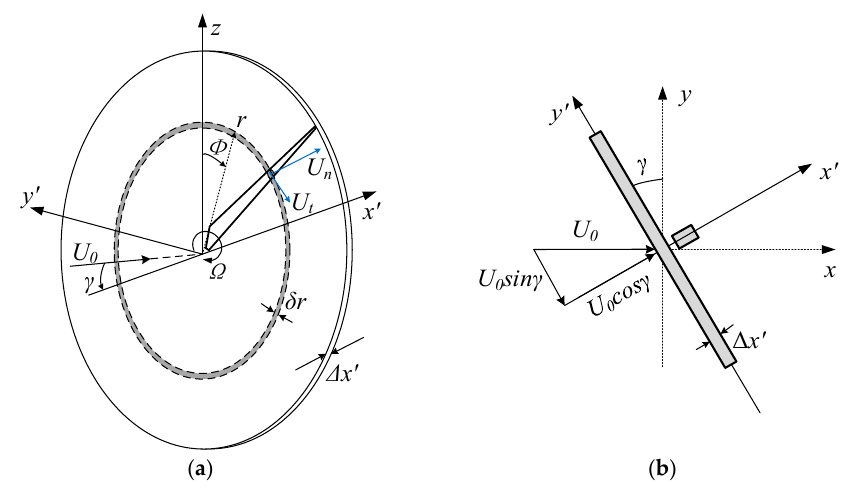
Figure 1. Schematic of the ADM-R model for the yawed rotor: ( a ) isometric view, ( b ) top view.